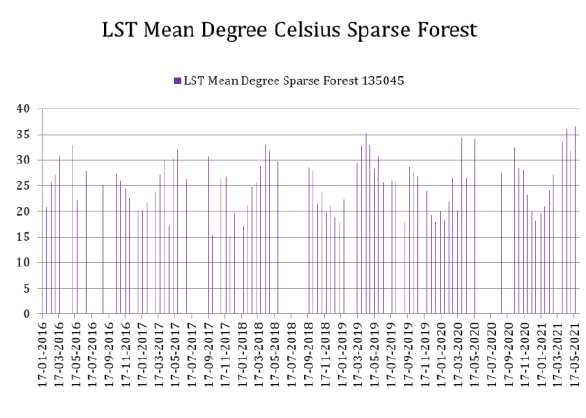
Fig. 7: LST Mean Degree Celsius for Sparse Forest region from